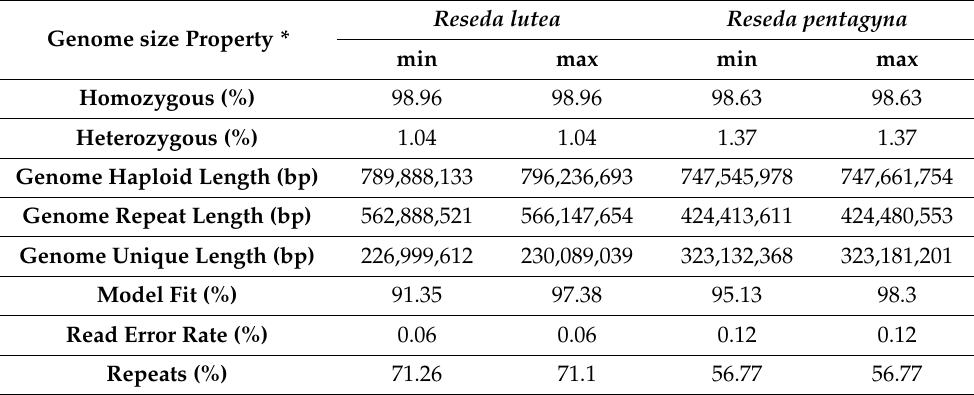
Table 5. Genome properties of Reseda lutea and Reseda pentagyna